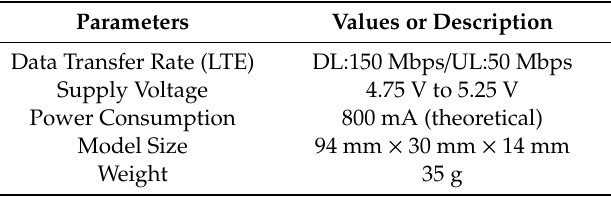
Figure 4. Fully assembled prototype of IoT sensing node. Table 2. Characteristics of HUAWEI USB 4G